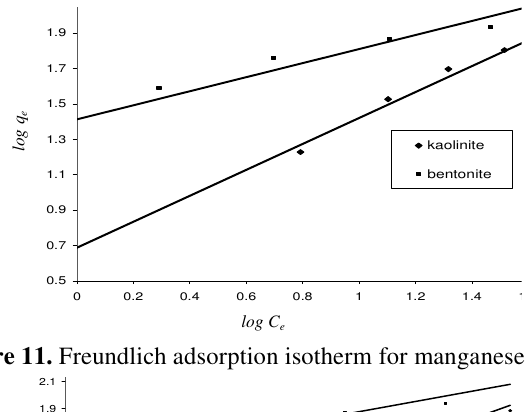
Figure 11. Freundlich adsorption isotherm for manganese(II)